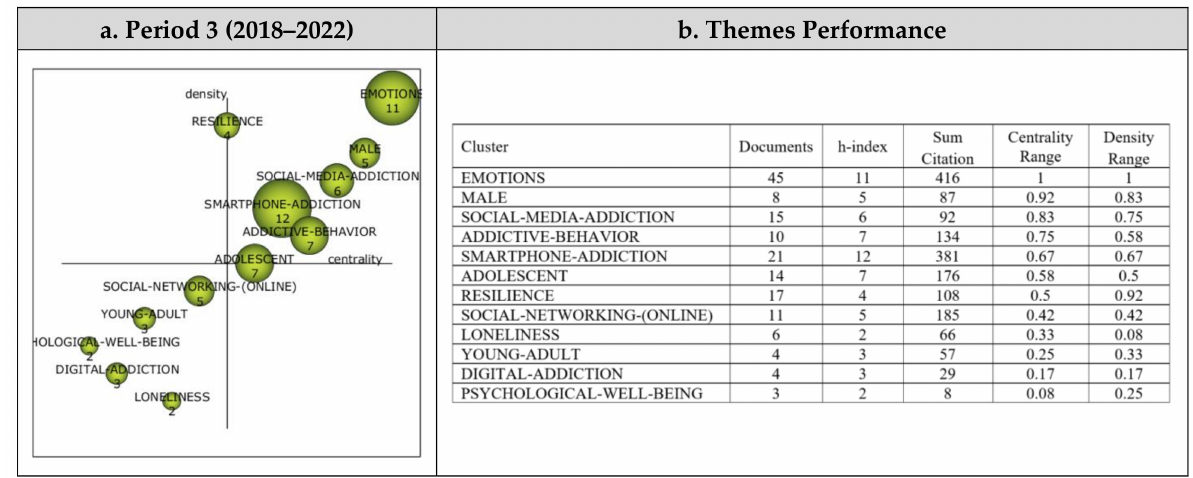
Figure 8. Period 3: ( a ) Strategic diagram and ( b ) performance